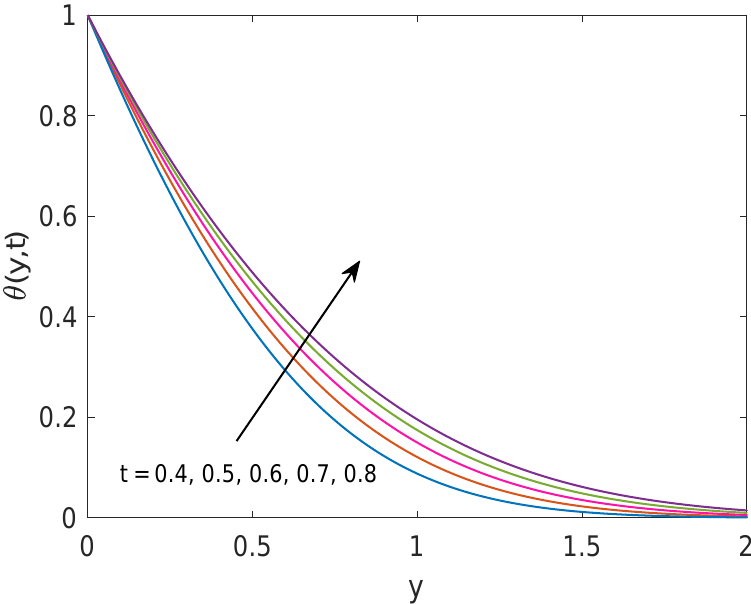
Figure 15. Temperature profile for different t when Pr = 6.2, Nr = 1.5, φ = 0.1 and Q =